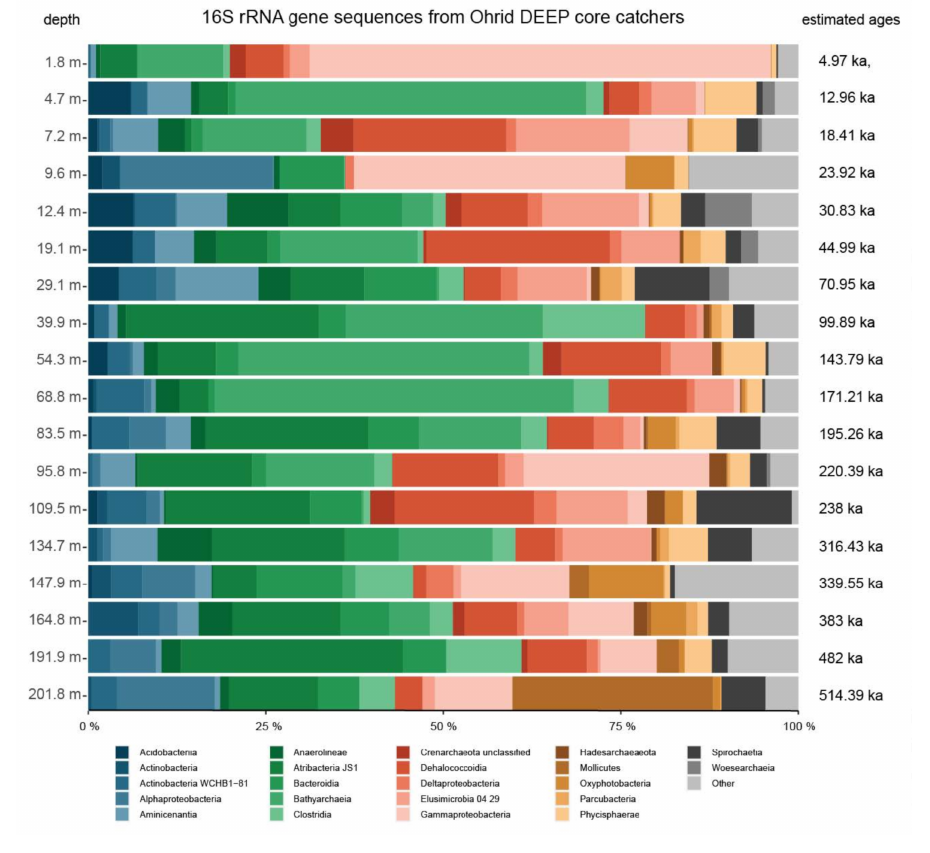
Figure 5. Relative abundance of 16S rRNA gene sequences per sample at the phylum level, and corresponding estimated ages for each